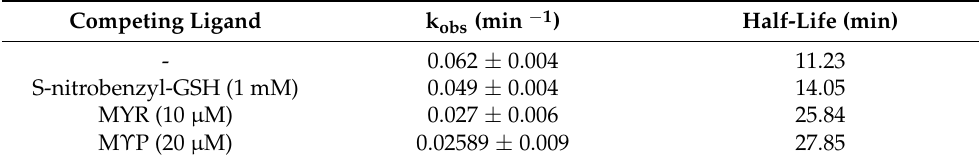
Table 1. Observed rates and half-time of hGSTA1–1 inactivation by PEITC in the presence of the competing ligands S-nitrobenzyl-GSH and